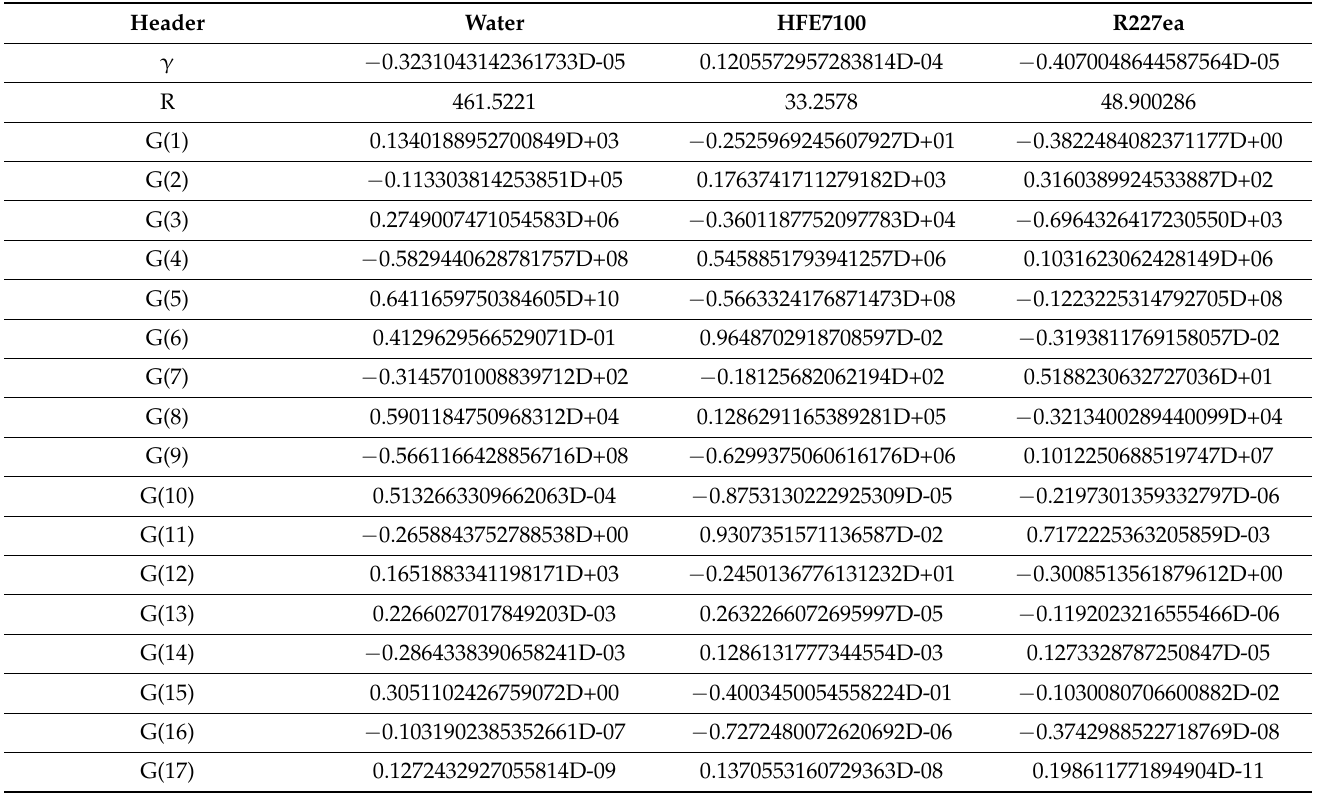
Table A1. The values of the constants of the mBWR32